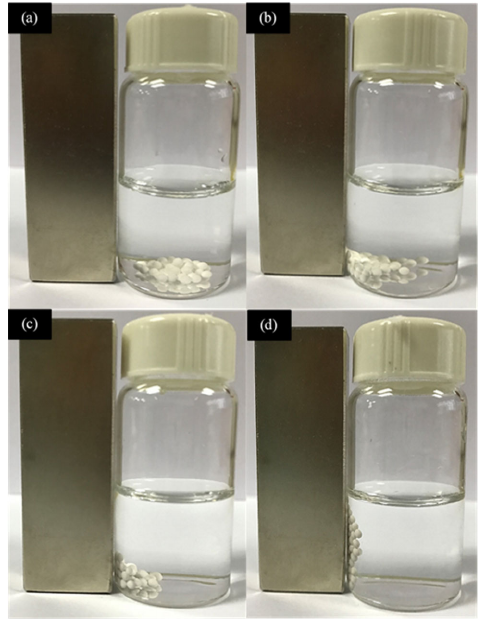
Figure 2. Magnetophoretic separation efficiency of ( a ) neat PESPVP microspheres, ( b ) PESPVP ‐ MNPs0.1, ( c ) PESPVP ‐ MNPs0.2, and ( d ) PESPVP ‐ MNPs0.5 microspheres.